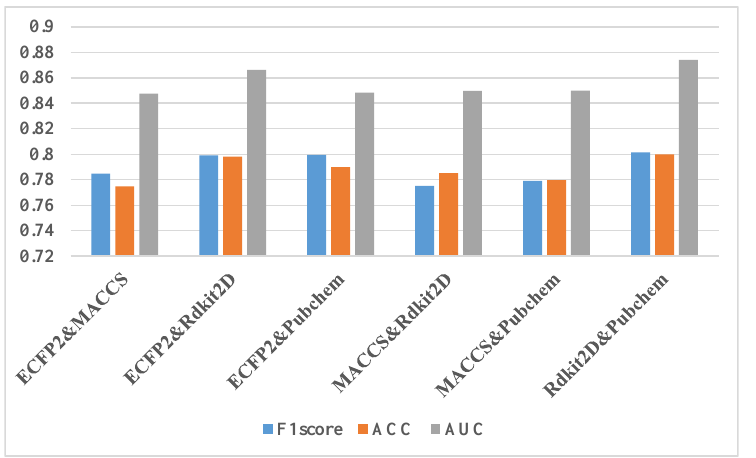
Figure 7. Results of ablation experiments by using only two fingerprints. “ECFP2&MACCS” means using the ECFP2 and MACCS part of the features from all the features, and so on for other labels.